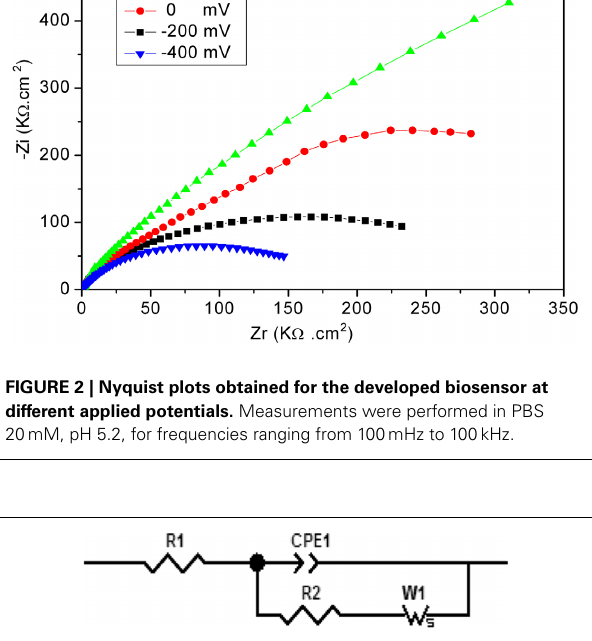
FIGURE 3 | Randles equivalent circuit.